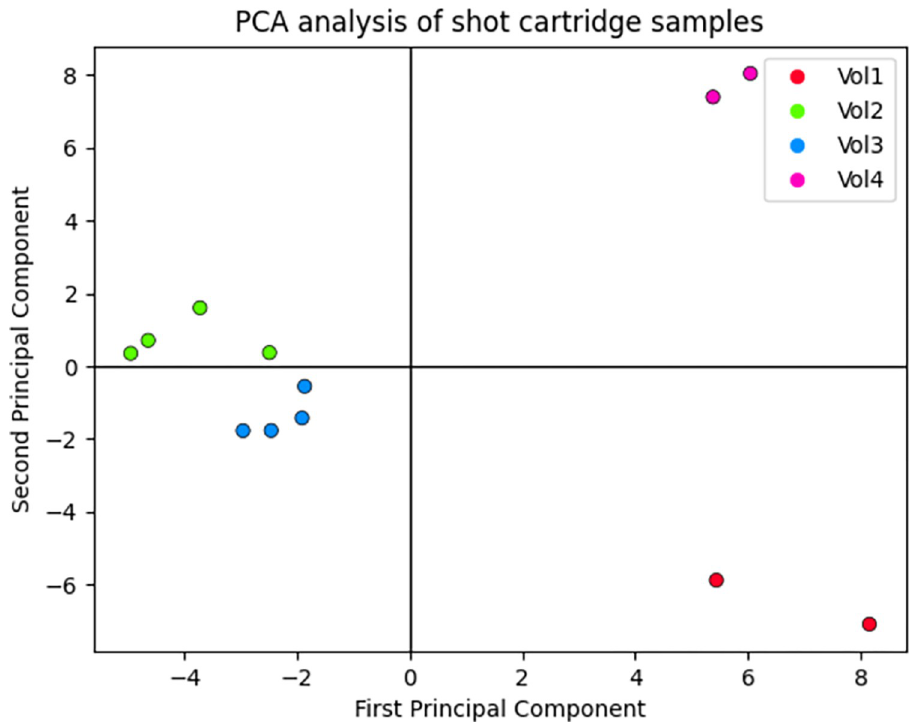
Fig 3. PCA of scent samples collected from shot cartridges. This model was based on N = 75 ratios with the lowest SD for each volunteer.The T was set to 50% non-zero values for each ratio across all samples. 65 peak area ratios are the 2 intersection of all volunteer sets, and these ratios were present in more than 50% across all inspected samples. The first two components described 59.75% of the data variance. Further comments on the PCA analysis setup are stated in S1